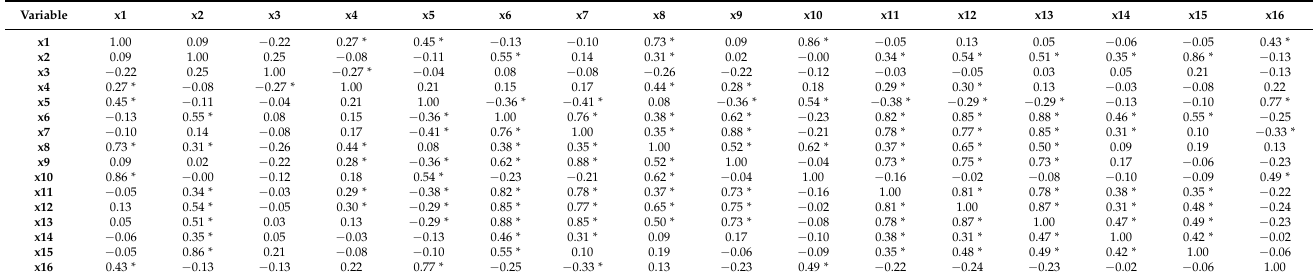
Table 4. A Pearson correlation matrix for the investigated